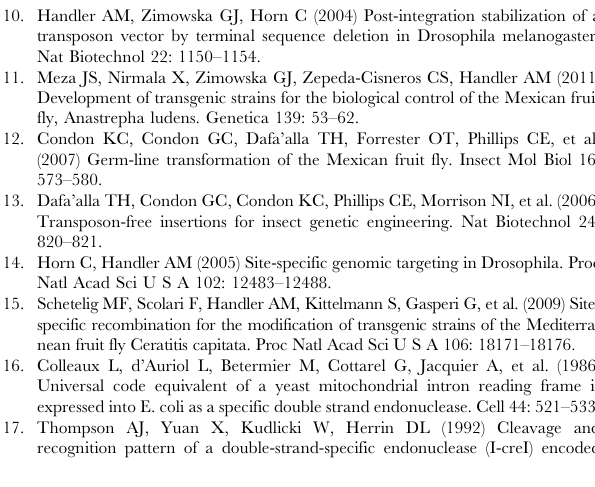
Table S1 Statistical analysis of vectors stabilization data. Table S2 Effectiveness of phiC31 -mediated transformation of embryos. Table S3 Predicted PCR products from TS51D, TS51D2xSce, TS58A2xSce inserted into landing platform and theirs derivatives. Table S4 Sequence of primers used in molecular analysis